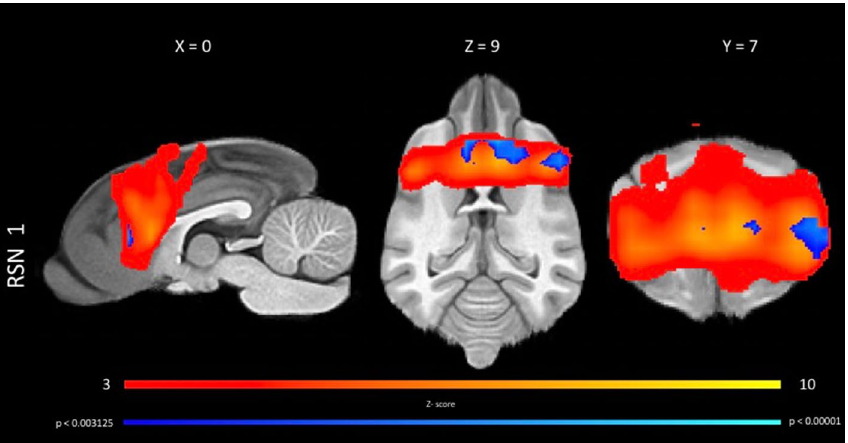
Figure 3. Results of the two-sample t tests for increased connectivity in the anterior DMN between the idiopathic epileptic dogs and control dogs in a sagittal, dorsal and transversal plane. The voxel with significantly increased connectivity (p < 0.003125) within the regions of the anterior DMN in epileptic dogs compared to healthy control dogs are shown in blue. The results are overlaid on the local false discovery rate controlled (p < 0.05) thresholded z-maps of the anterior DMN, with red-yellow color encoding using a 3 < Z-score threshold and on a T1W open-source stereotactic atlas 46 . This figure was created using FSLeyes (version 2.1 https:// fsl. fmrib. ox. ac. uk/ fsl/ fslwi ki/ FSLey es) and Microsoft Powerpoint (version 16.16.19, http:// www. micro soft. com).